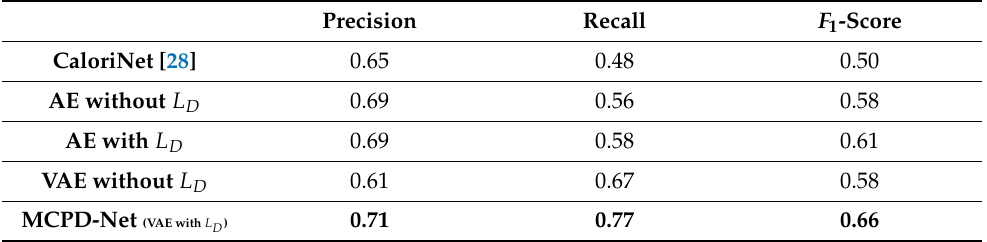
Table 2. MCPD-Net vs. other multimodal architectures. This demonstrates the superiority of MCPD- Net, due to its VAE models and cross-modality regularisation L D